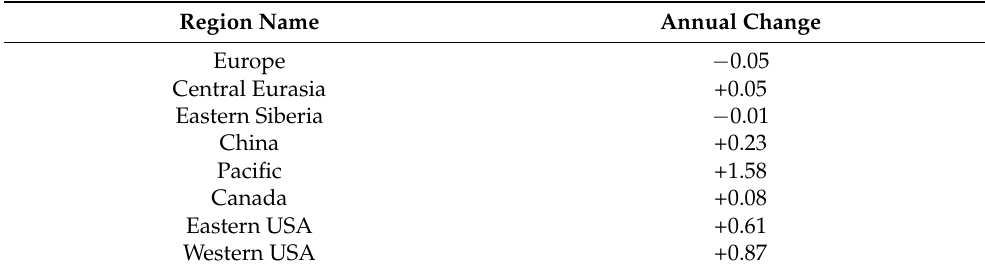
Table 1. Regionally averaged annual trend of values in surface—500 mb precipitable water (mm per decade) for 1973–1995 [13].